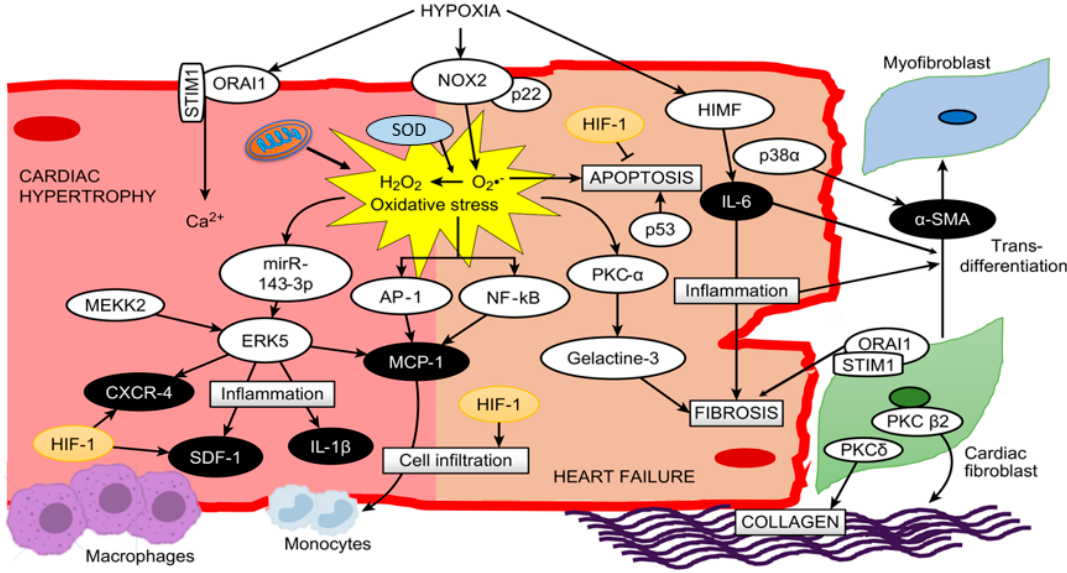
Figure 1. A proposed scheme summarizing all described molecular pathways and cells involved in cardiac hypertrophy and heart failure under hypoxia.